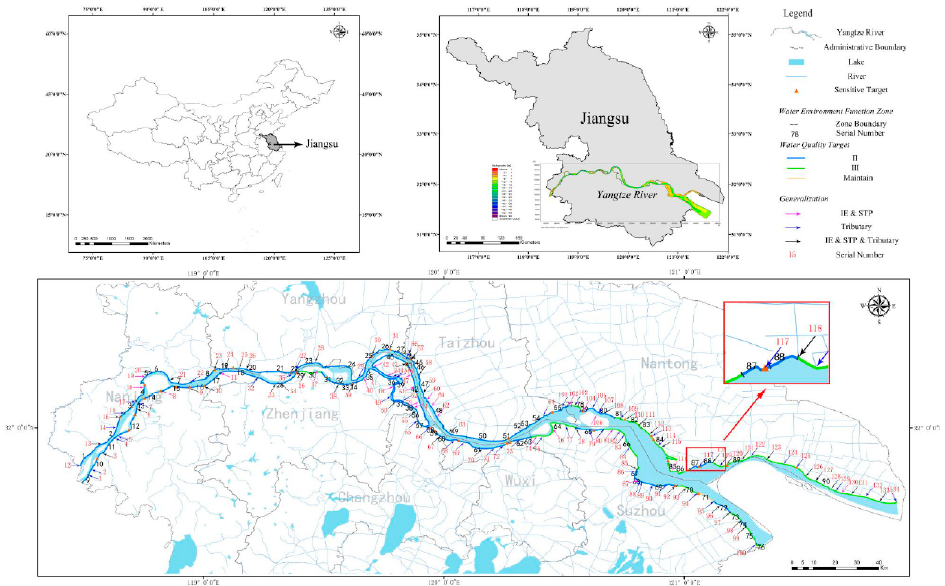
Figure 1. Study area and pollution source generalization map: industrial enterprises (IE); sewage treatment plants